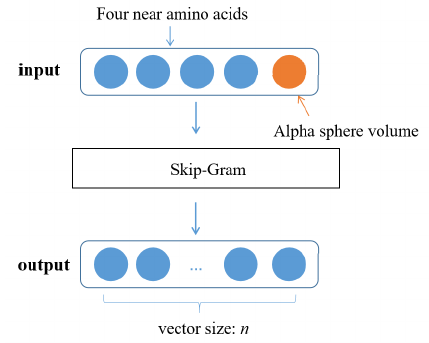
Figure 5. Input and output of Word2vec word vector.